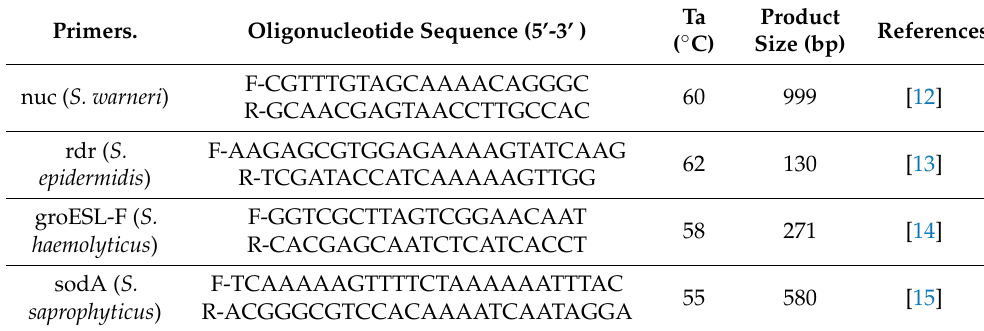
Table 1. Primers used in the species identification of MRCoNS.